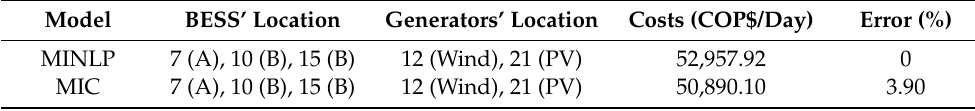
Table 6. Numerical results for the MIC and MINLP models in Case